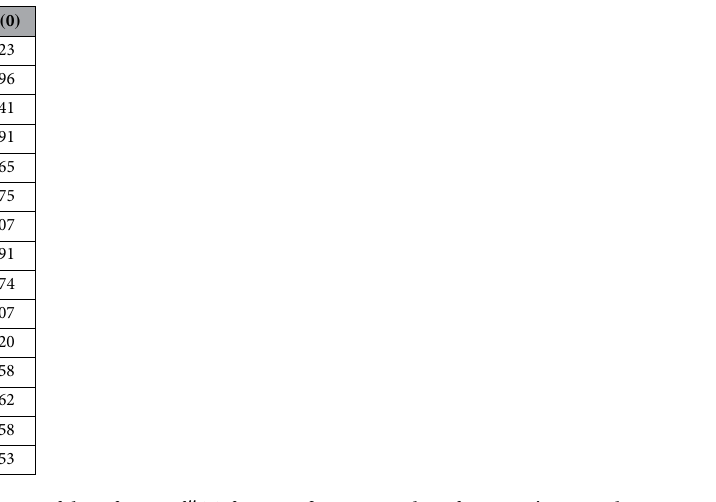
f ′′ ( 0 ) for specific magnitudes of M , Nr , (cid:31) , Me and Nc −